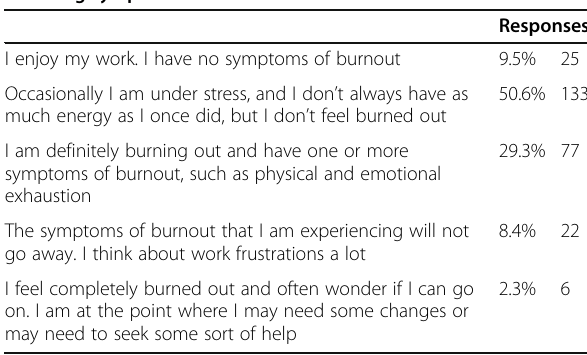
symptoms of ‘ burn-out ’ ? (survey